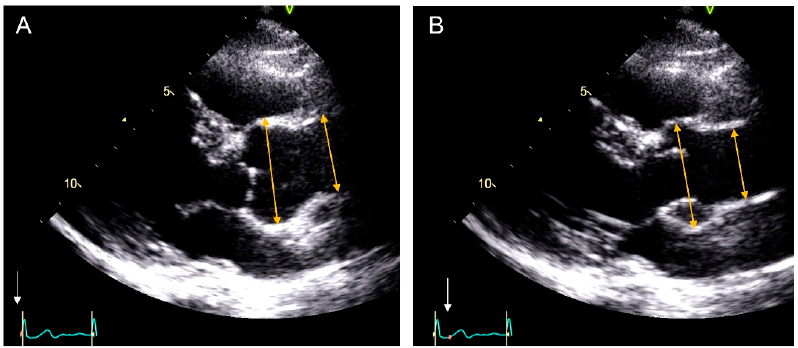
Figure 1. Measurement of maximum aorta diameters by echocardiographic images in parasternal long-axis view. Aortic root and ascending aorta measuring technique as recommended by the ASE guidelines for adults (leading-to-leading edge in diastole) ( A ) and by the ASE guidelines for children (inner-to-inner edge in systole) ( B ). The white arrows mark the measurement time-points in relation with the cardiac cycle oh the electrocardiogram (ECG).